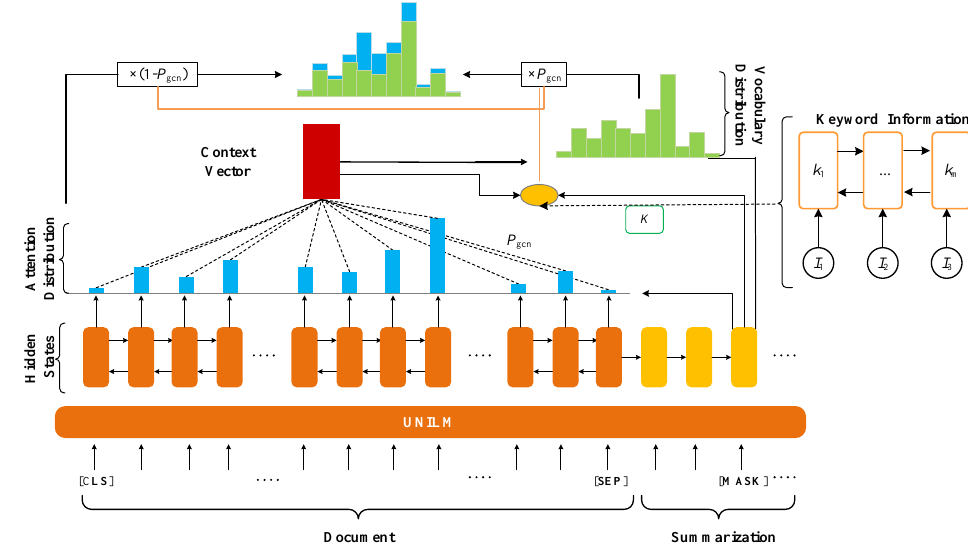
Figure 5. The overall of summary-generation model. Our model was based on a unified pre-training language model. We introduced keywords into the text-generation model as an attention mechanism. Furthermore, we introduced sparse softmax and a copy mechanism into our model to avoid over- fitting and any factual deviation in the generated